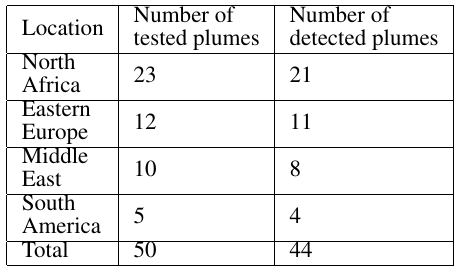
Table 2. Comparison of the number of detected plumes versus the number of tested plumes in the dataset proposed by (Lauvaux et al., 2021)